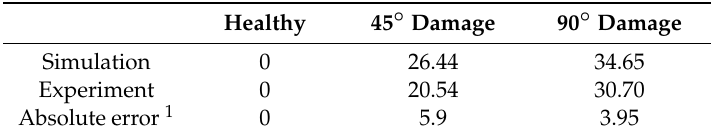
Table 6. Comparison of the evaluation index.